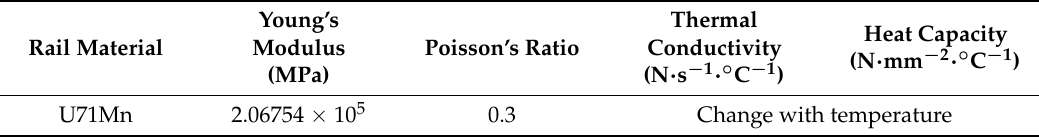
Table 3. Main physical property parameters of the rail material.